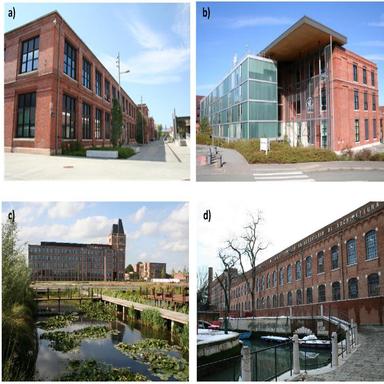
Examples of industrial sites and buildings: in eastern France a) and b) Techn'hom – business development zone, adaptive reuse of the old spinning factory Dollfus, Mieg & Cie (Belfort, France), b) currently: General Electric European headquarter Marina Gasnier, 2016 (architect: Reichen and Robert); c) Adaptive reuse of the Le Blan-Lafont textile factory in an urban activities area dedicated to information and communication technologies (architect: Vincent Brossy). In the foreground: the water garden, an elem